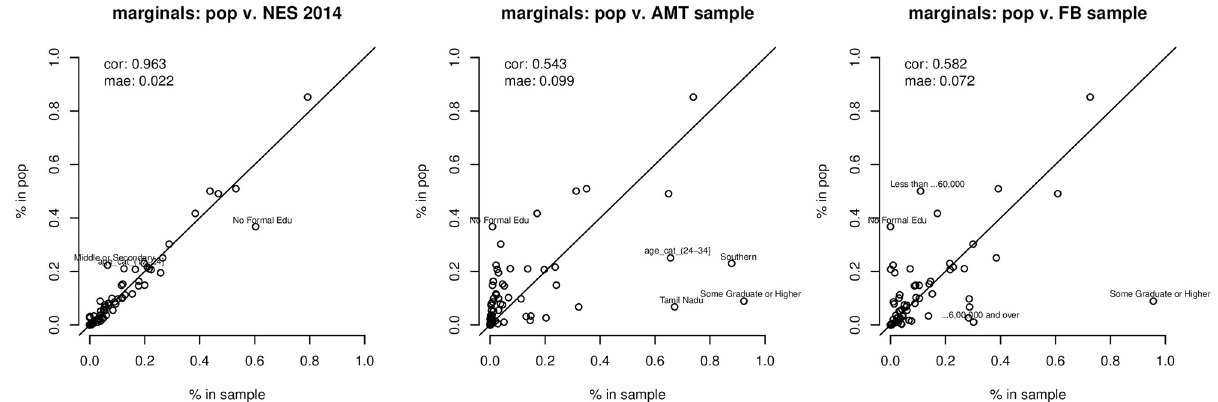
Fig 3. National vote share for the three major alliances over the course of the campaign; monitoring stops before the beginning of voting, and vote-share after this point.